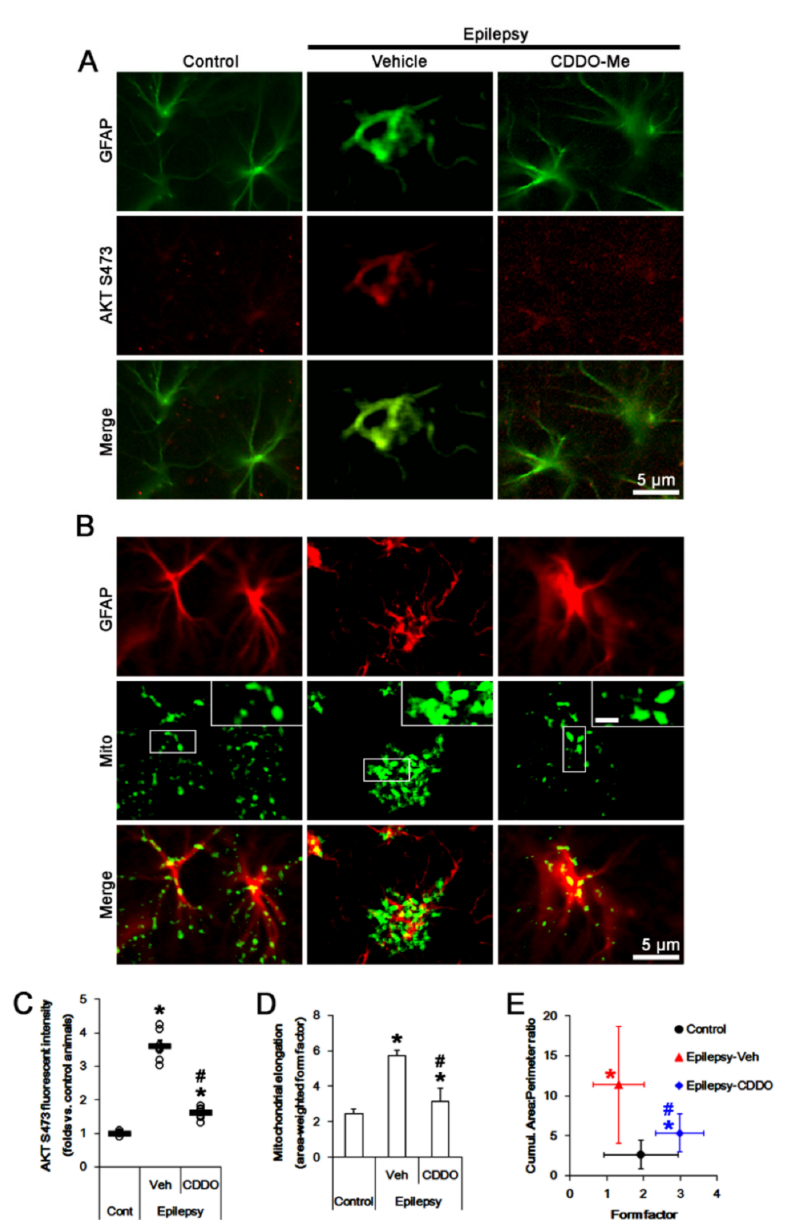
Figure 2. Effects of CDDO-Me on AKT S473 phosphorylation and mitochondrial length in CA1 astrocytes of control and epileptic rats. As compared to control animals (Cont), AKT S473 phos- phorylation and mitochondrial length are increased in CA1 astrocytes in epileptic rats. CDDO-Me reduces AKT S473 phosphorylation and mitochondrial length in CA1 astrocytes, as compared to vehicle (Veh). ( A , B ) Representative photos demonstrating astroglial AKT S473 phosphorylation ( A ) and mitochondrial morphology ( B ) in CA1 astrocytes. ( C – E ) Quantifications of AKT S473 phos- phorylation (mean ± S.E.M.; *, # p < 0.05 vs. control and vehicle-treated epileptic rats,